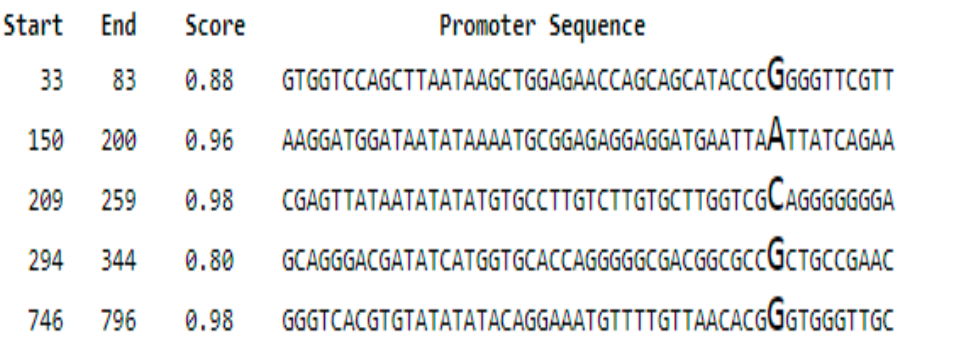
Figure 11. Predicted transcription start site in TPD1 promoter with % probability.